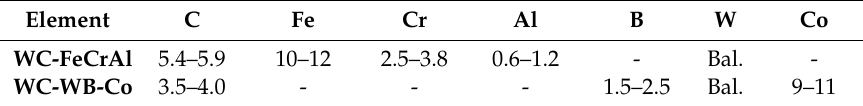
Table 2. Chemical composition of feedstock powders (wt. %).